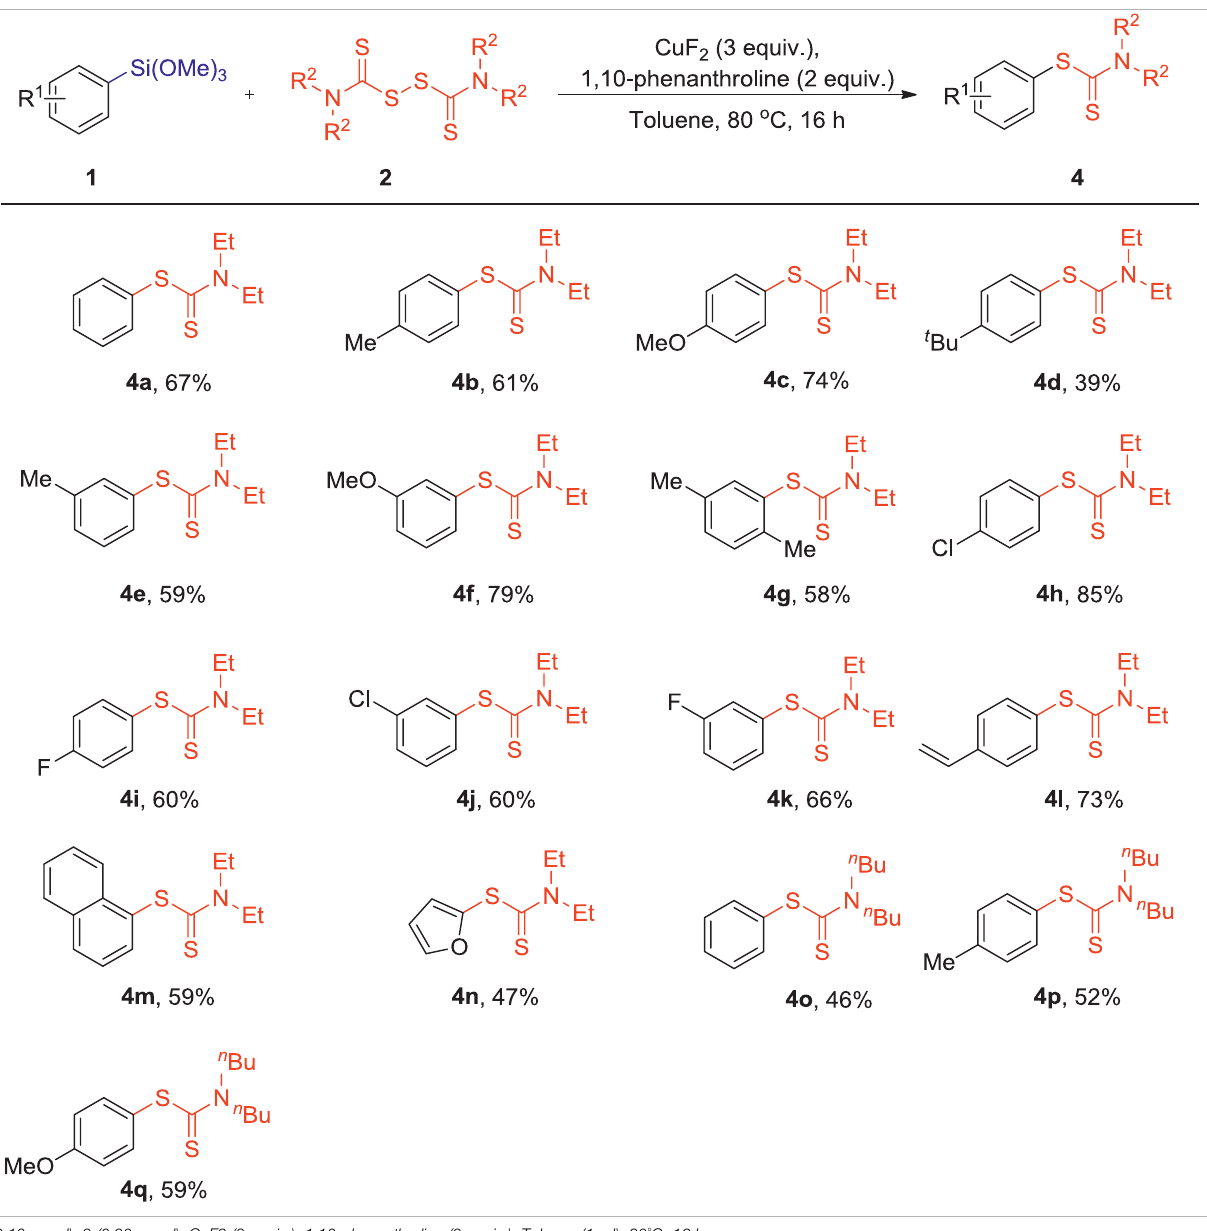
TABLE 3 | Reactions of arylsilanes 1) with tetraalkylthiuram disul fi des (2) a,b